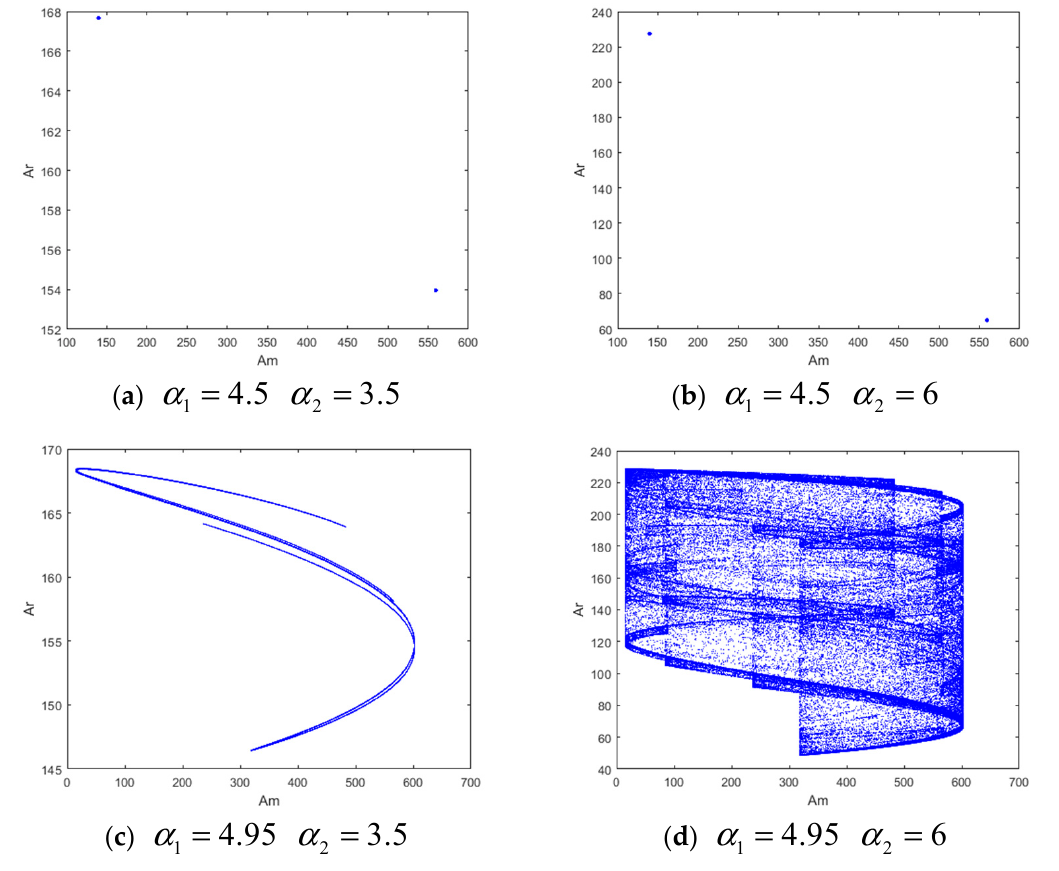
Figure 5. The attractors of system with different α 1 and α 2 . The corresponding Double Largest Lyapunov Exponents (DLLE) with respect to α 1 and α 2 are shown in Figure 6a,b. The blue areas are LLE < 0 with a color transition from dark blue to light blue. When the LLE tends to 0, the color becomes light khaki and the system is in period-2 and period-4 stable cycles, etc. The dark khaki areas with the LLE > 0 means the system is in chaos and divergence. Researchers can see the trend of system state from order to disorder by the perspective of LLE.